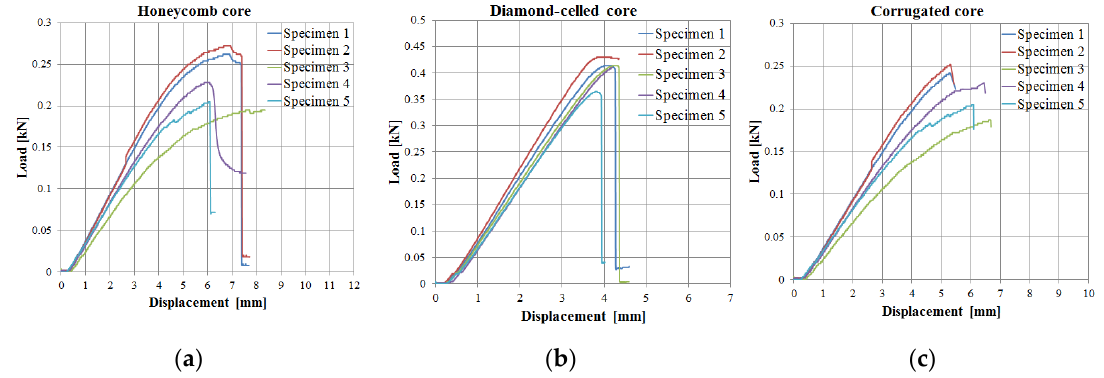
Figure 12. Load–displacement curves obtained from three-point bending tests: ( a ) honeycomb core; ( b ) diamond-cell core; ( c ) corrugated